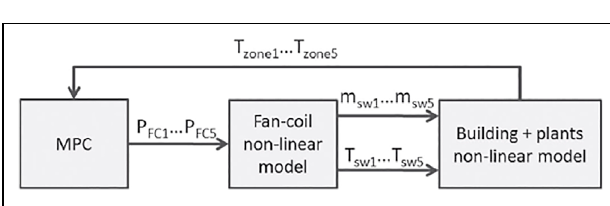
FIGURE 9 | Control architecture. MPC computes a power value to be delivered to each zone. This value is filtered by a compensator to become a valid value for the HVAC